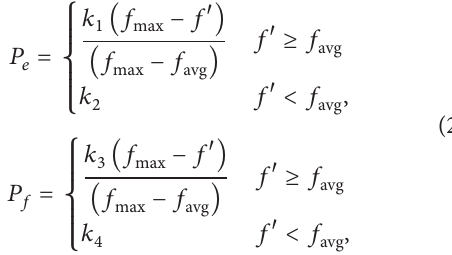
Figure 4: Result of